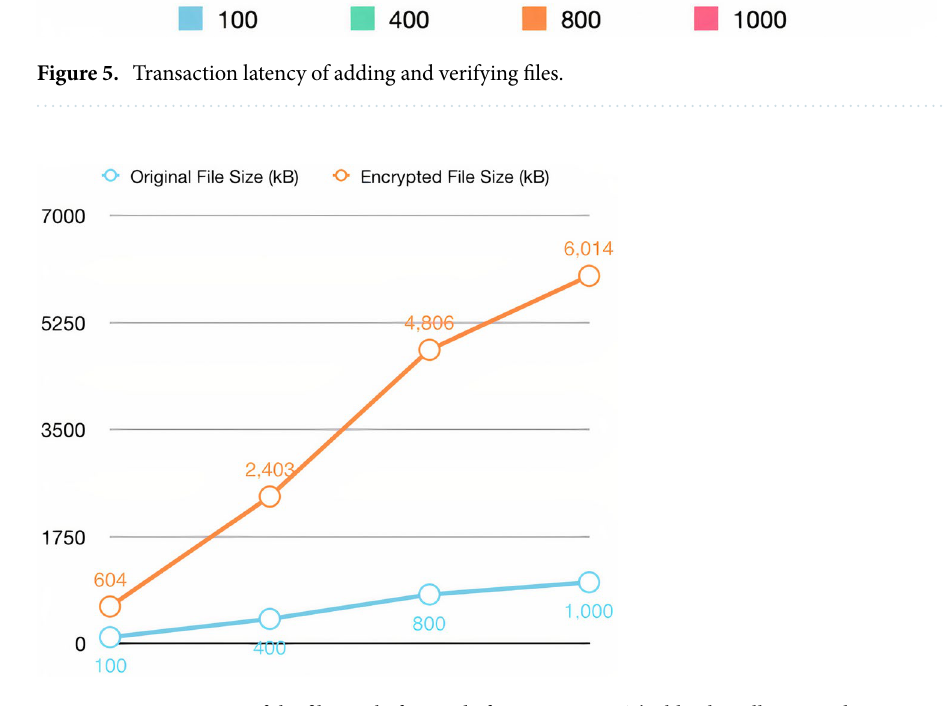
Figure 6. Comparison of the file size before and after encryption. The blue line illustrates the unencrypted file size, and the orange line indicates the encrypted file size.